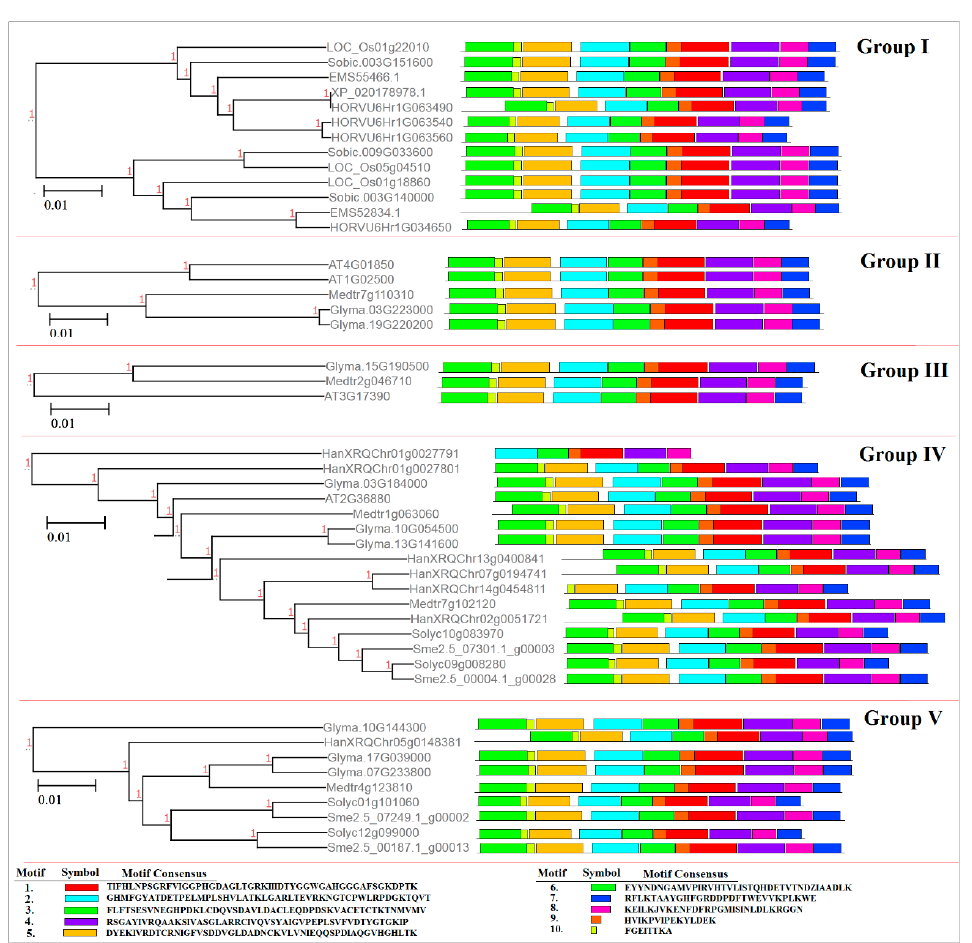
Figure 3. Conserved motif distribution of SAMS proteins in the studied plant species predicted using the MEME v4.12.0 server. Plants 2020 , 9 , x FOR PEER REVIEW